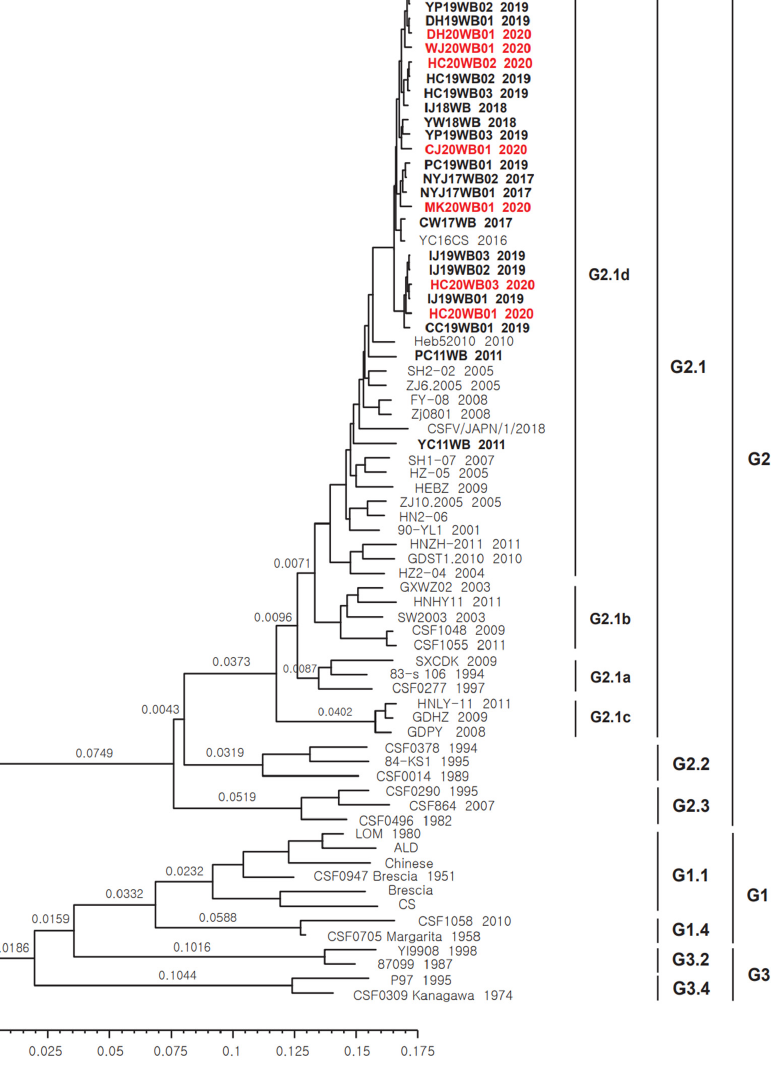
Figure 1. Phylogenetic tree of CSFV partial E2 gene sequences. MCC tree analysis of 70 CSFV strains, including 25 CSFVs isolated from wild Korean boars, was conducted using the BEAST program. CSFVs from wild Korean boars are marked in black bold font (2011–2019) and red bold font (2020). Bar = branch age.